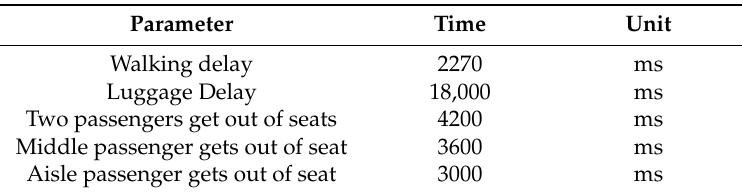
Table 2. Various delay values